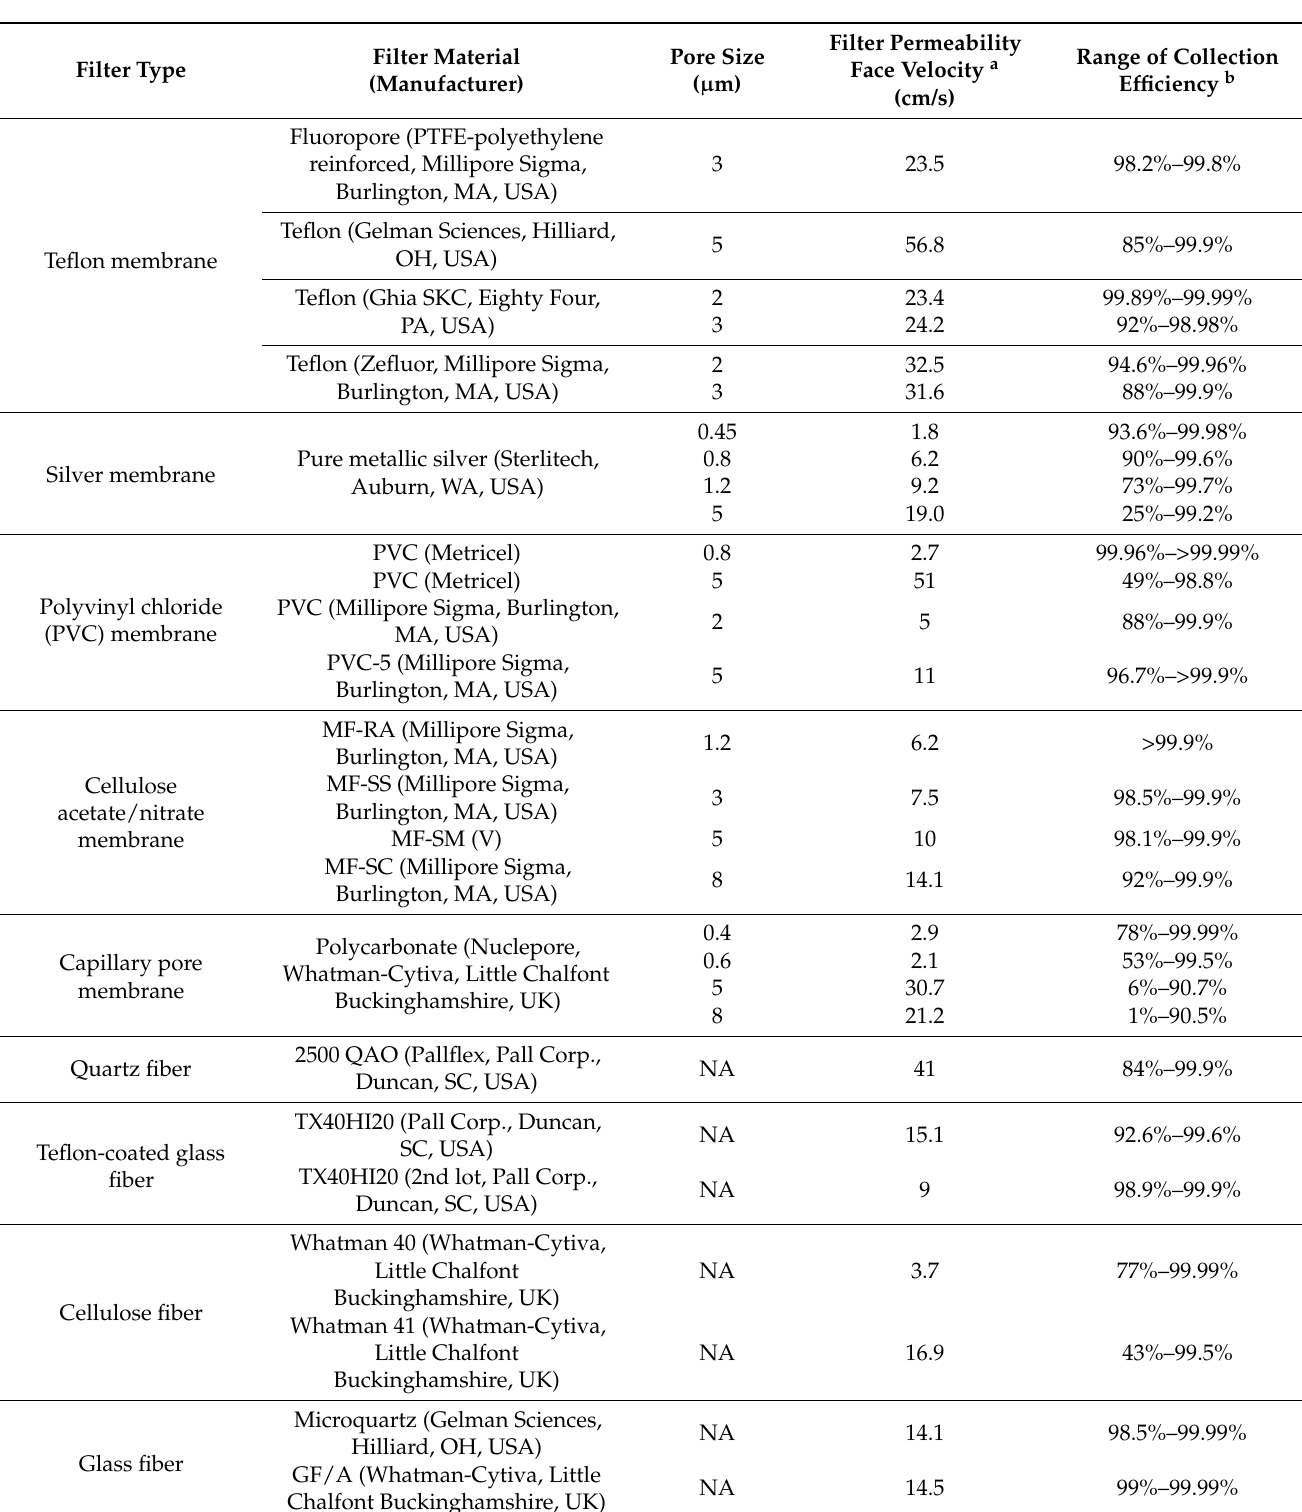
Table 2. Filter types, pore sizes, permeabilities, and collection efficiency for filters applicable to mine exposure monitors